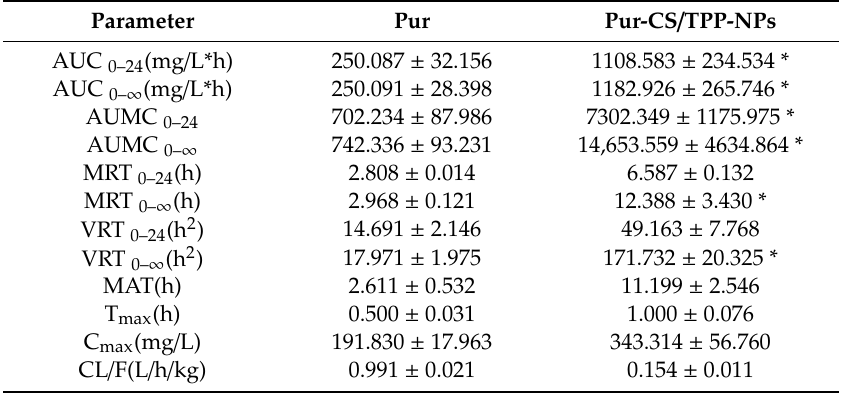
Figure 4. Whole blood concentration versus time profiles of Pur and Pur-CS / TPP-NPs after oral ( n = 9, ⎯ x ± s). Table 6. Pharmacokinetic parameters of Pur and Pur-CS/TPP-NPs.